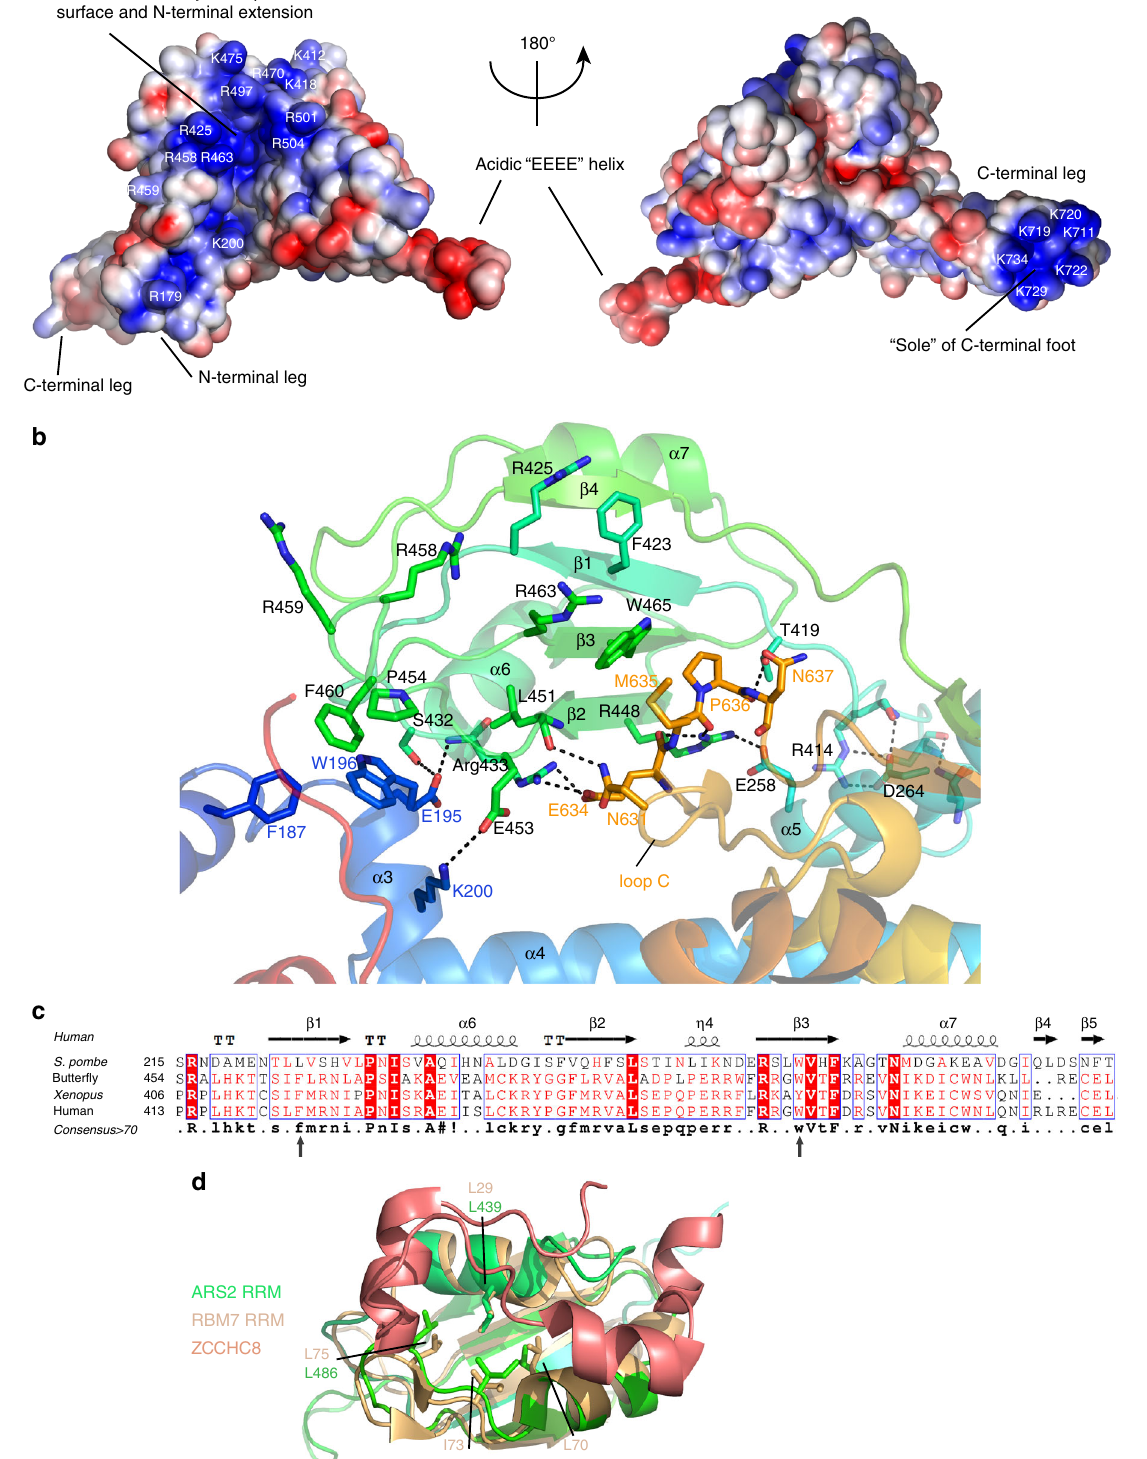
Fig. 2 Structural features of the ARS2 RRM domain. a Electrostatic surface potential (red – ve, blue + ve) calculated in PyMOL for two orientations of human ARS2. Basic residues contributing to the two negatively charged patches are shown, as well as the positively charged ‘ EEEE ’ helix in loop B. b View of the RRM domain showing the exposed β -sheet residues R463 and W465 (RNP1) and F423 and R425 (RNP2) and interactions holding the RRM in place, notably via loop C residues. Putative hydrogen bonds are indicated with black dotted lines. c Sequence alignment of the S. pombe , butter fl y, Xenopus and human RRM domain of ARS2 with superposed secondary structure. Conserved aromatic residues within the RNP motifs of metazoans are indicated with arrows. d Superposition of ARS2 RRM domain (green ribbons) with the RRM domain of RBM7 (yellow) bound to a ZCCHC8 peptide (salmon) (PDB:5LXY [10.2210/pdb5LXY/pdb]). Identical residues forming a hydrophobic surface that in the case of RBM7 binds the ZCCHC8 peptide are displayed as